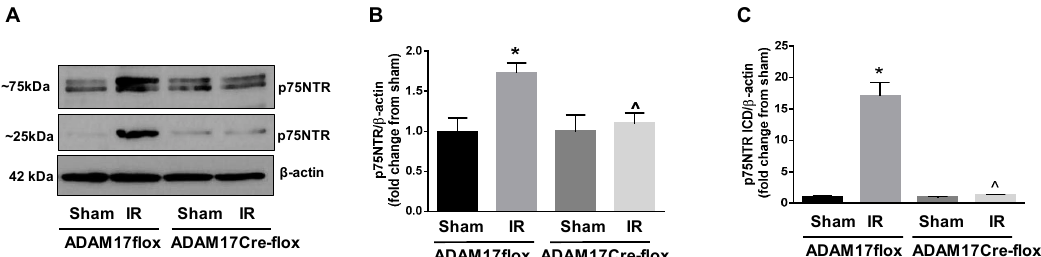
Figure 8. Genetic ablation of endothelial ADAM17 reduces proteolytic processing of p75NTR in IR-injured retinas. ( A ) Representative blots of the full-length (~75 kDa) and cleaved fragment of p75NTR (p75NTR ICD; ~25 kDa) in retinal extracts from control ADAM17flox and ADAM17Cre-flox mice 6 h after reperfusion. ( B ) Densitometric analysis of full-length p75NTR and ( C ) cleaved p75NTR. Actin was used as an internal control. Values are mean ± SE. Results are presented as fold of change of sham. * p < 0.05 vs. corresponding sham; ^ p < 0.05 vs. ADAM17flox IR; n = 5 in each group.